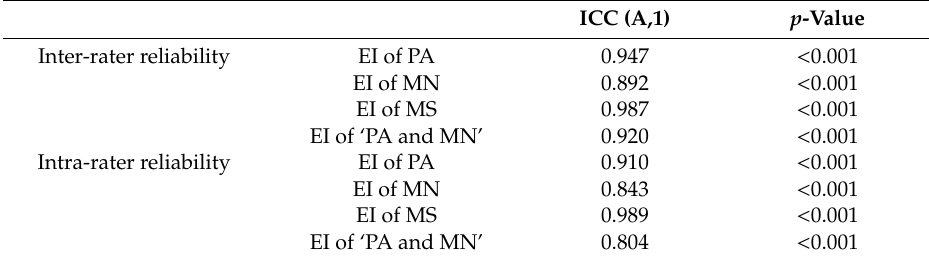
Table 2. Inter-rater and intra-rater reliability of US in control subjects.